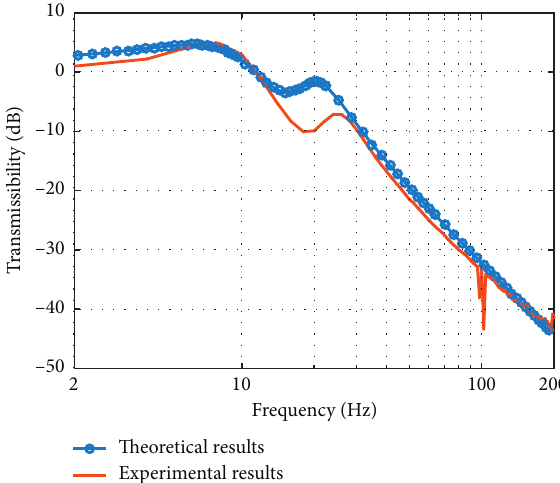
Figure 16: Y -direction acceleration curve.